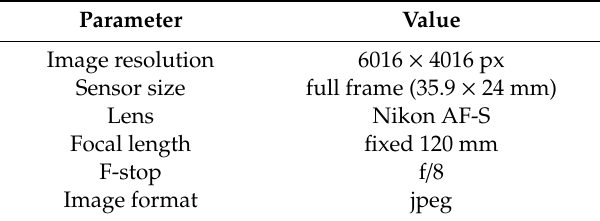
Table 1. Camera specification.